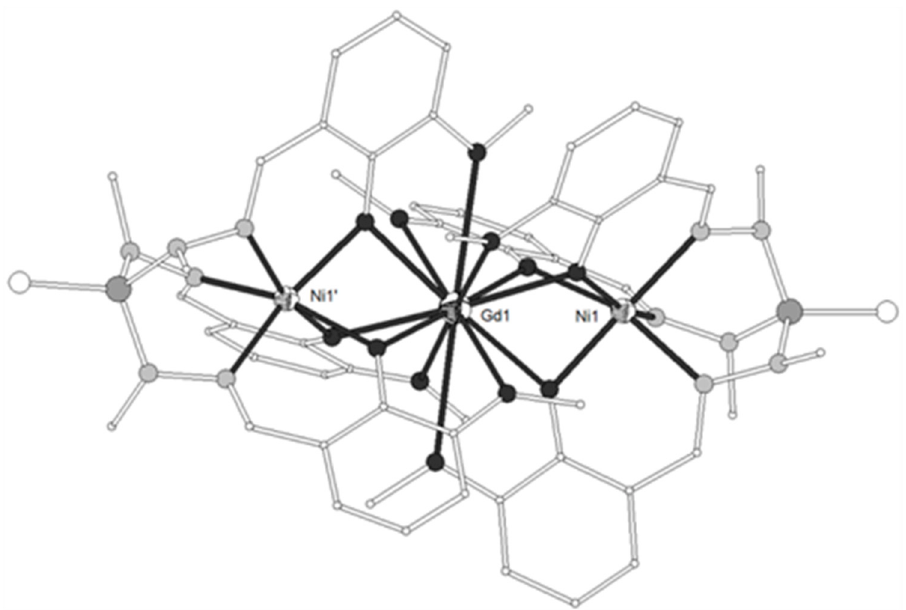
Figure 1. The molecular structure of the cation [(NiL 1 ) 2 Gd] + in complex 7 . Primed atoms are generated by symmetry: (‘) = − x , y , 1 − z . Color code: Gd large octant, Ni small octant, N light grey, O dark grey, C open small, P grey large, S open large [17].